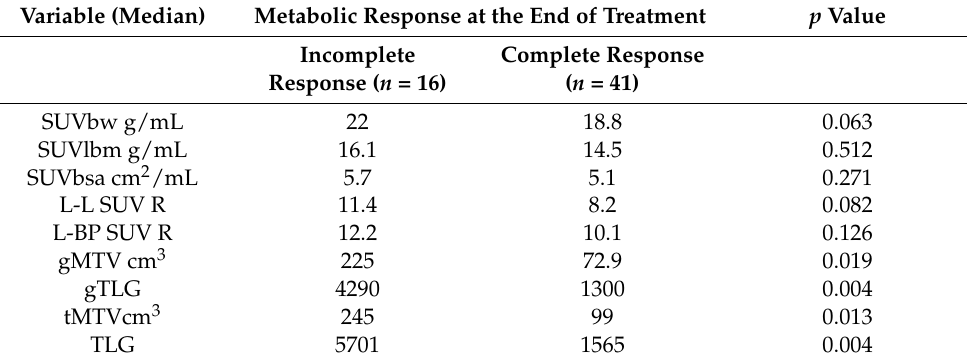
Table 2. Comparison between different metabolic response groups at end-of-treatment considering the main PET/CT baseline